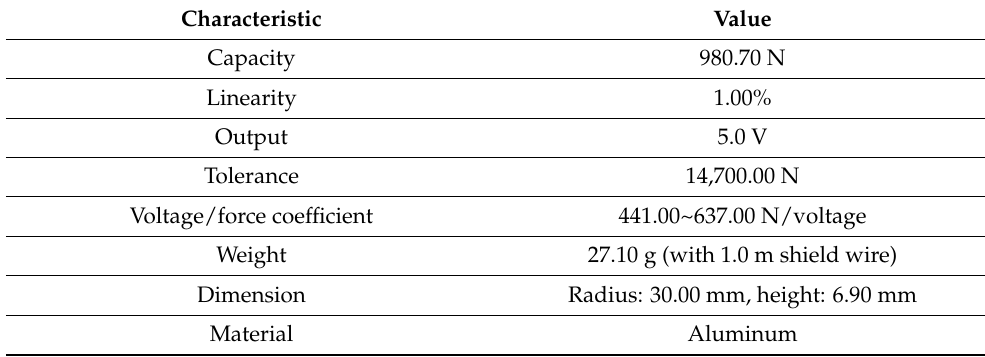
Table 1. Characteristic of EzForce-1D